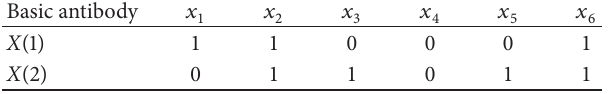
Table 1: An example of basic antibody.